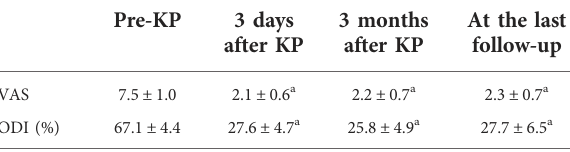
TABLE 1 Mean improvement in VAS and